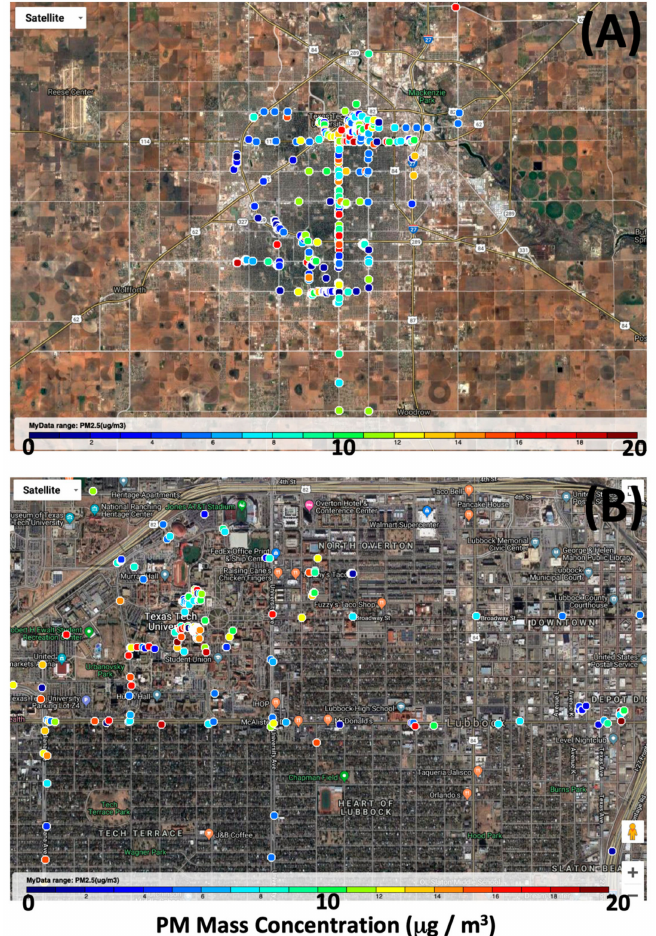
Figure 7. Maps of Lubbock, TX with user sampled PM single-point data superimposed. Mobile sensors transmitted GPS coordinates and dust sensor PM measurements to a webserver, and maps were created from data. Map in ( A ) is approx. 40 km wide by 28 km high. Map in ( B ) is zoomed to illustrate specific locations sampled by users during their experiences. Data point colors describe an individual observation PM mass concentration in µ g m − 3 and are not meant to represent trends or